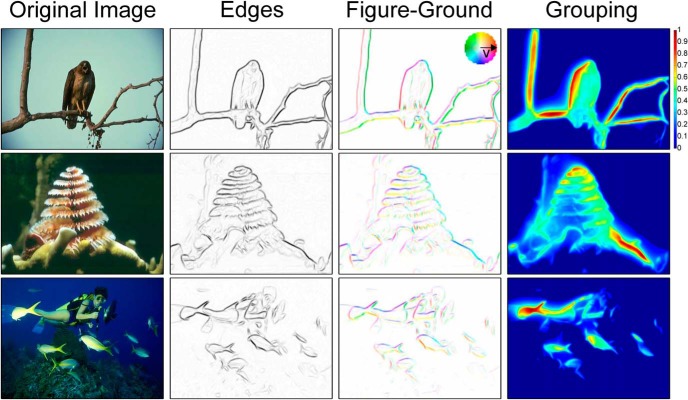
Example results of our model on images from the Berkeley Segmentation Dataset. Columns from left to right are the original images, the edge activity, the border ownership cell activity (representing figure-ground assignment), and grouping cell activity. For the figure-ground assignment, each edge is represented by a hue and a saturation value (see color wheel inset). The hue of the edge represents the figure-ground orientation label with the arrow convention shown in the color wheel (e.g., red represents an object located to the right) and the saturation of the edge represents the strength of the BOS. Grouping cell activity is color coded and normalized, with warmer colors representing higher activity (see color bar at right).